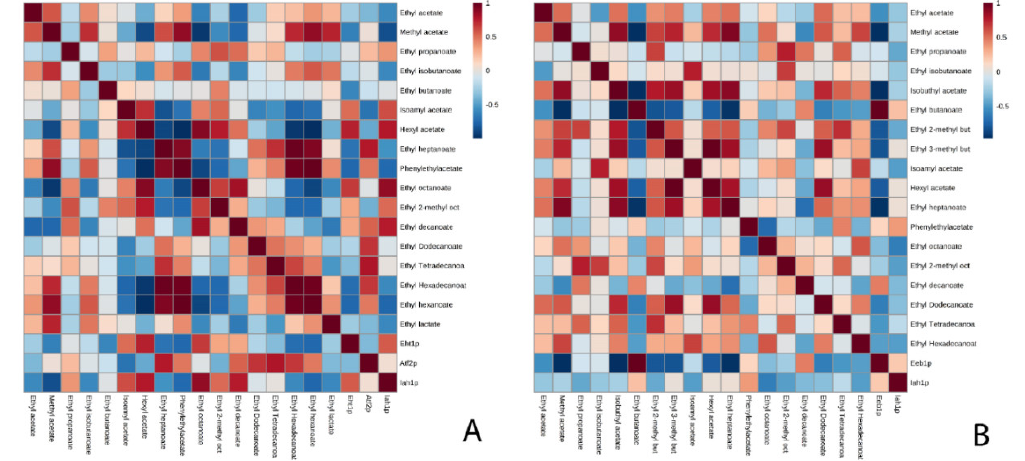
Figure 3. Matrix resulting from the analysis of correlations made for the CO 2 overpressure condition in flor yeast ( A ) and in the P29 strain ( B ) with a confidence level of 95%.